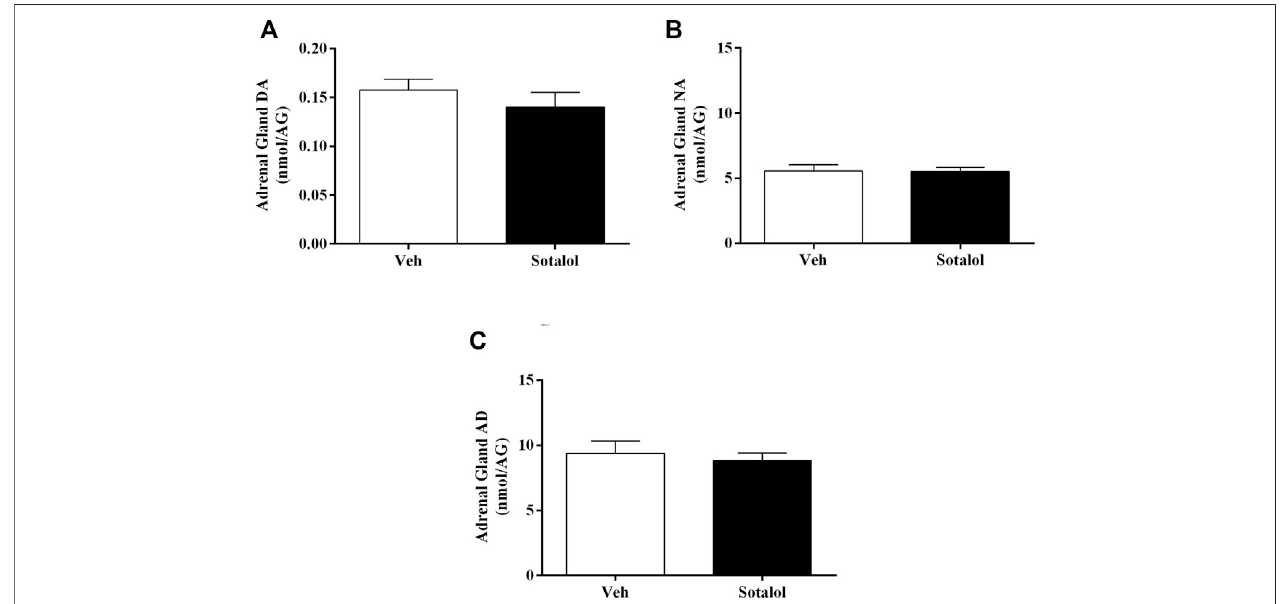
FIGURE 7 | Concentration of adrenal gland (A) dopamine (DA), (B) noradrenaline (NA), and (C) adrenaline (AD) after post-traumatic stress disorder (PTSD) induction (day 14). Values are means ± SEM of 6-7 mice per group. Veh, vehicle-treated PTSD mice; Sotalol, sotalol-treated PTSD mice.